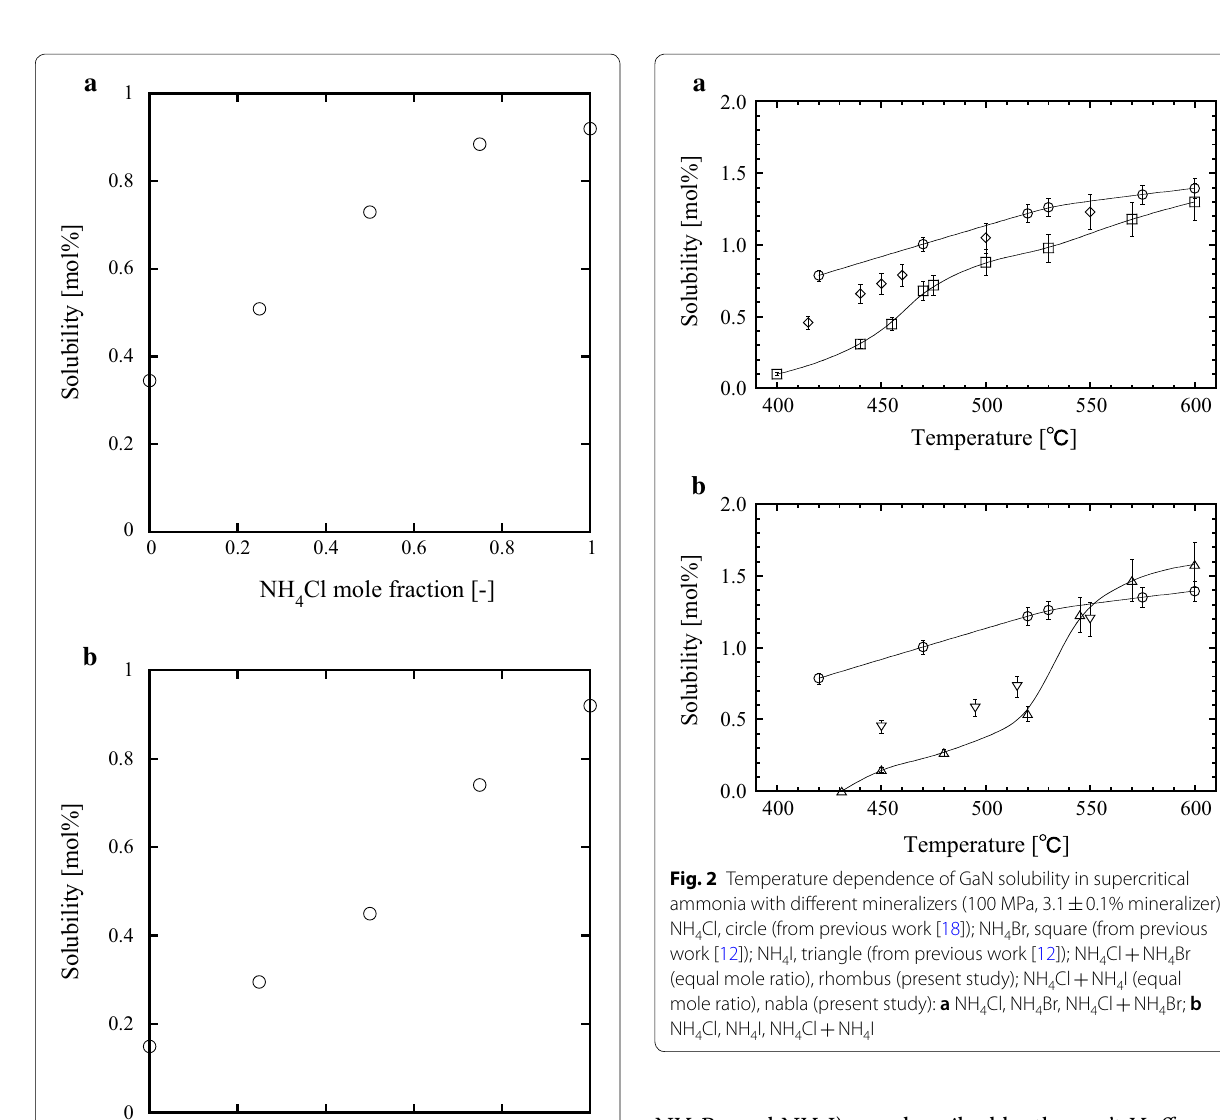
0.1% mineralizer): ± NH 4 Br + NH 4 I (equal + NH 4 Br; b +